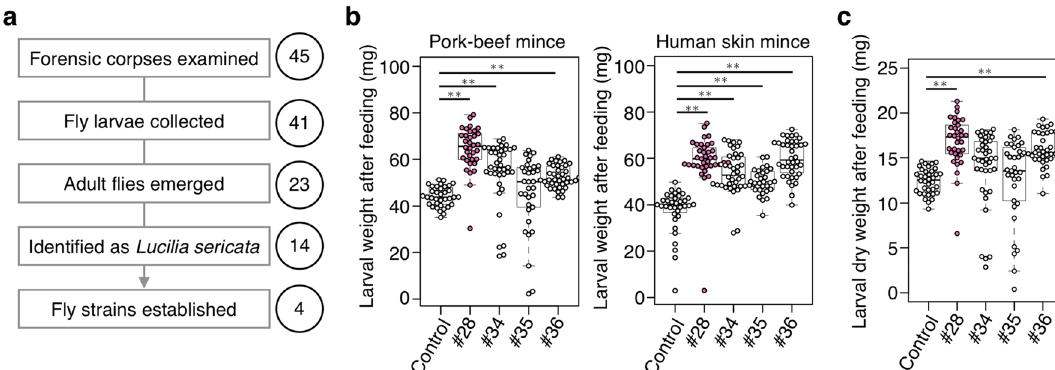
Figure 3. Analysis of carrion fly species collected from human corpses. ( a ) A flow chart of collecting fly larvae and identifying L. sericata from forensic corpses. Each number indicates the human corpse examined. Four L. sericata strains (#28, #34, #35, #36) were established. ( b ) Weight of larvae supplied with 24 g of pork-beef mince (left) or human skin mince (right). Weight was measured at 5 days (left) and 4 days (right) after hatching. n = 40 per group. ( c ) Dried weight of larvae at 5 days after hatching supplied with 24 g of pork-beef mince. n = 40 per group. In ( b ) and ( c ), each dot represents the weight of an individual larva. Boxplots: center line, median; box range, 25th–75th percentiles; whiskers denote minimum–maximum values. Student’s t -test, ** p < 0.01. See also Supplementary Data 1 for data of experiment, exact sample sizes, and p